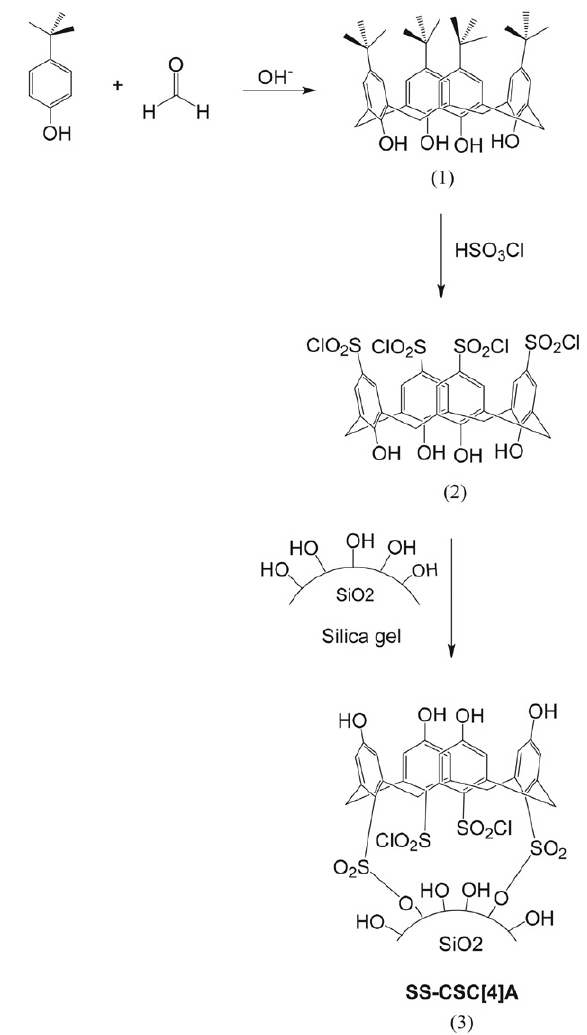
Figure 1. The synthetic strategy for silica-supported